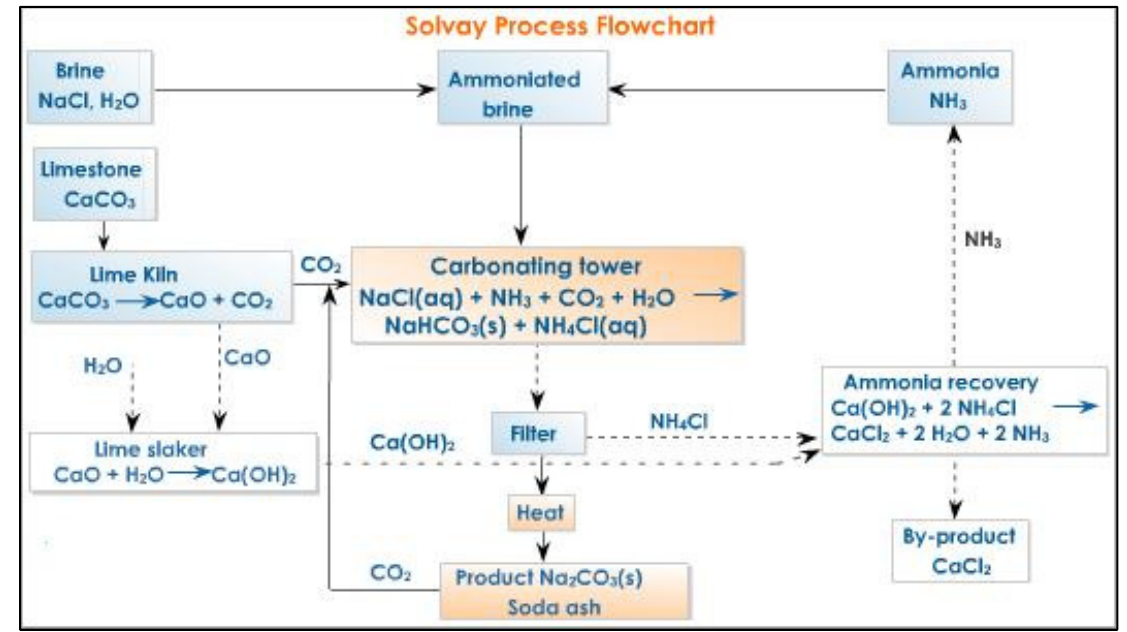
Figure 1. Solvay process .